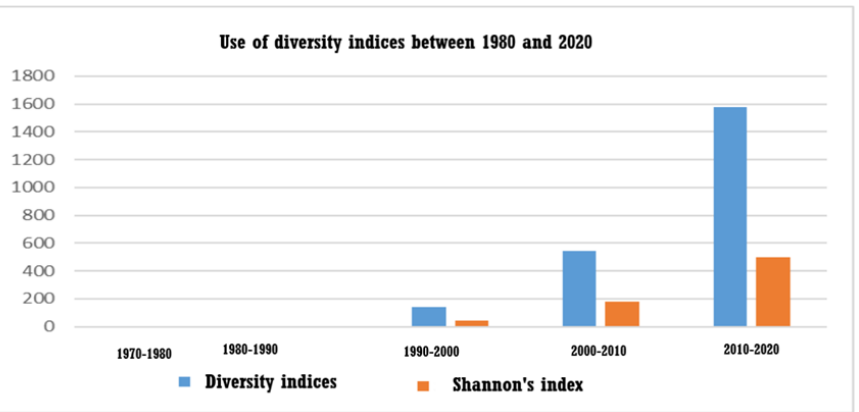
Figure 1. Use of diversity indices over the last fifty years in scientific publications referring to the marine environment. There has been an exponential increase in the use of diversity indices in general, as well as Shannon’s index , which is the most popular. The number of publications that these indices appeared in during the 1970s was exceptionally low, but their use started to grow during the 1990s, mainly due to their use for water quality studies and ecosystem health evaluation. Source: Clarivate (Web of Science) —search items used: Diversity indices marine / Shannon’s indices marine .